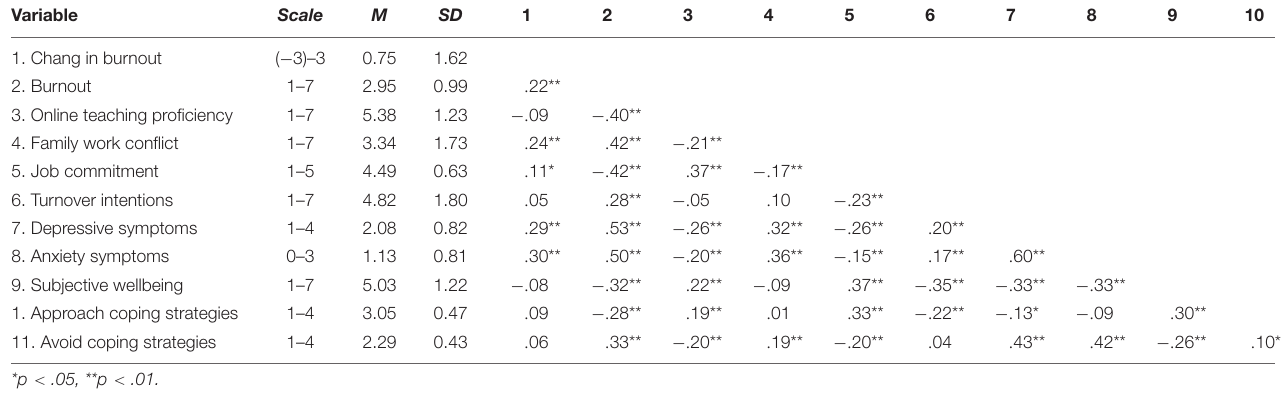
TABLE 2 | Means, standard deviations, and correlations of key variables ( N = 399). Variable Scale